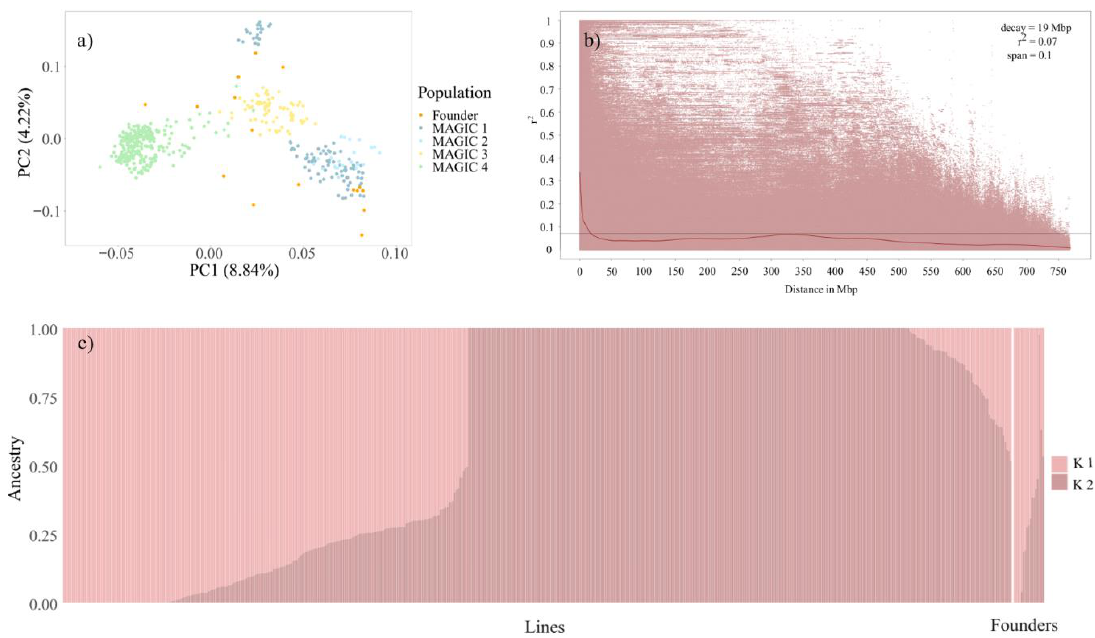
Figure 2. Analyses of population structure and linkage disequilibrium (LD) decay for the combined panel, MAGIC 1 to 4. ( a ) Principle component analysis (PCA) plot of the first two components, colored according to population; ( b ) genome-wide LD decay plot, with r 2 plotted against the physical position (Mbp), the horizontal line represents the LD decay threshold ( c ) Population structure revealed by STRUCTURE analysis.